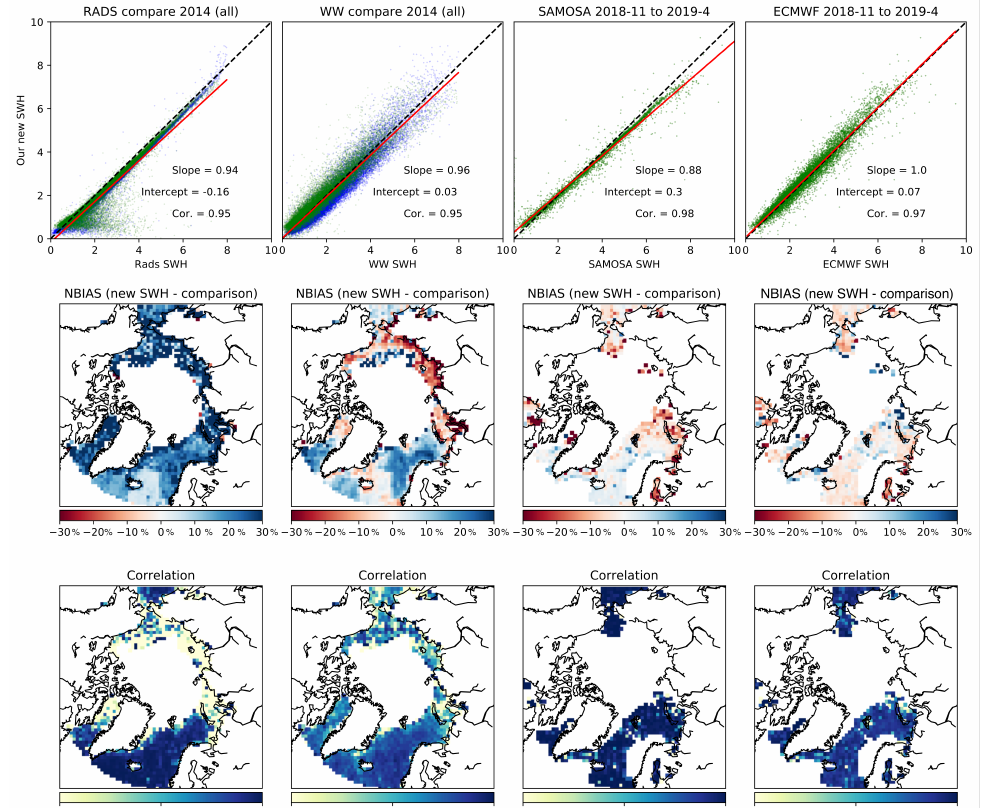
Figure 5. Comparisons between our new SWH data product and existing CS2 derived data sets and models. Comparisons are performed after binning the individual tack data onto a 100 km grid. The first column is for SWH from the RADS data. Column 2 is for the WaveWatch 3 model data. Column 3 is for the SAMOSA data. Column 4 is the ECMWF model data. The top row shows scatters comparing our data and the comparison data for both LRM (blue) and SAR (green) modes (SAR mode only processed by SAMOSA). The second row shows the Normalised Bias (NBIAS) (new SWH as a percentage of the comparison SWH) and the bottom row shows the correlation between our new SWH and the comparison data for daily averaged data for the time series listed